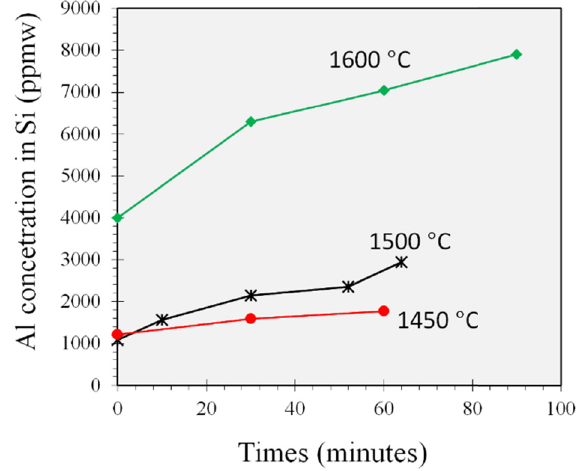
Figure 7: Aluminum concertation in liquid Si over time of gas re fi